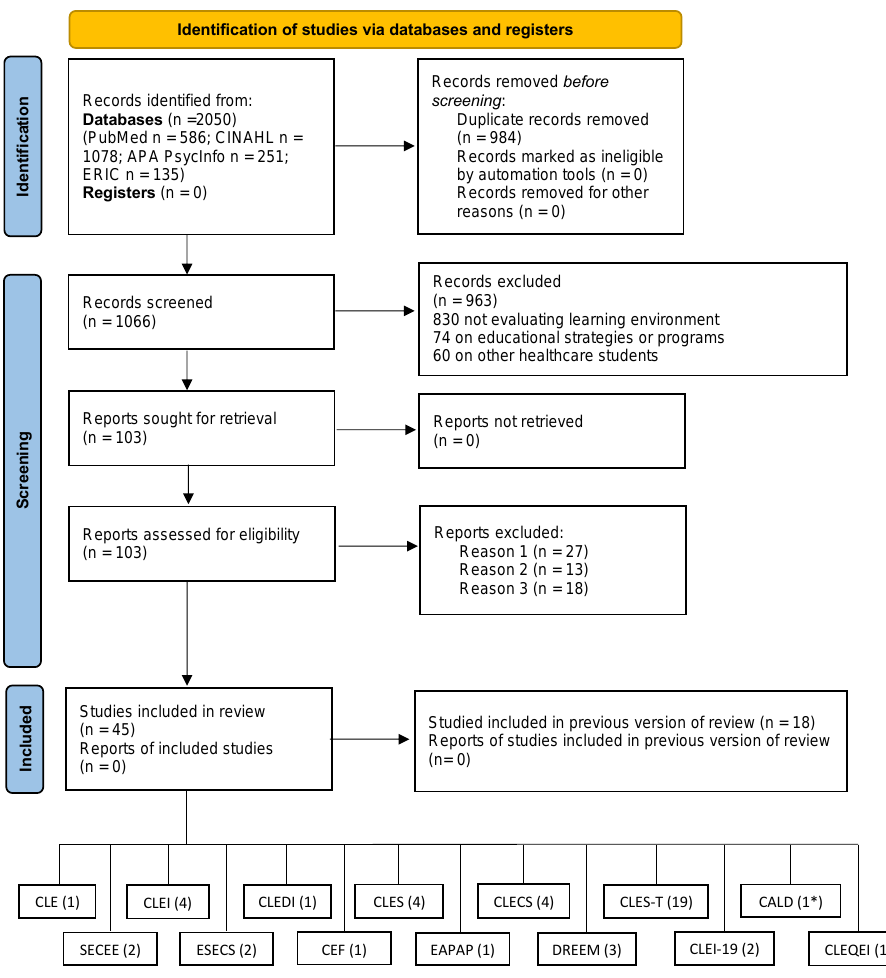
Figure 1. PRISMA 2020 flow diagram for new systematic reviews, which included searches of databases and registers only.